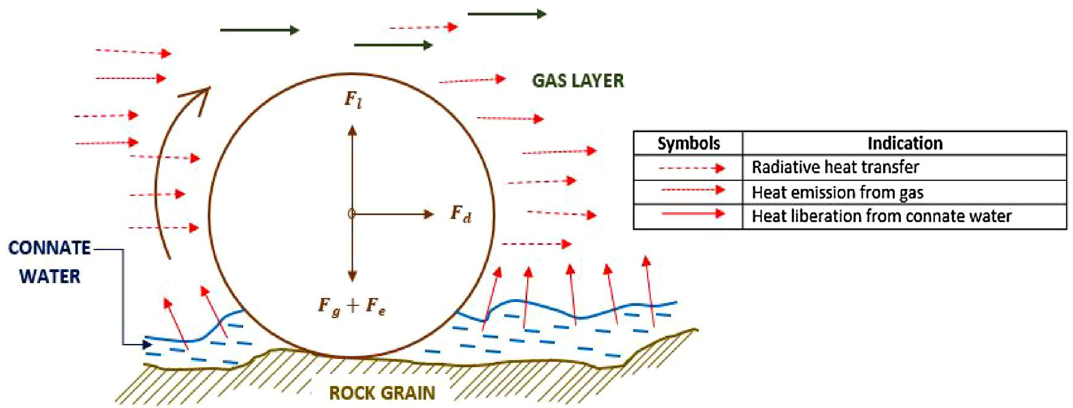
Fig. 2 Attached fine particle under the regime of mechanical forces during gas and heat flow in porous rocks with the presence of connate water. This image is a modified or extended version of Zeinijahromi et al.